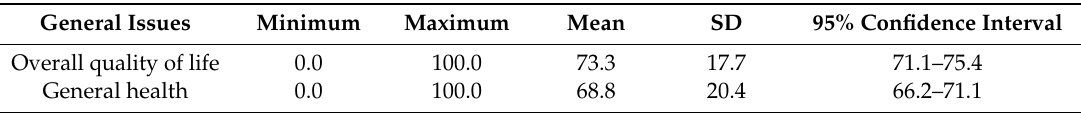
Table 2. Scores of each of the general issues of World Health Organization Quality of Life abbreviated version (WHOQOL-BREF) of prison o ffi cers.